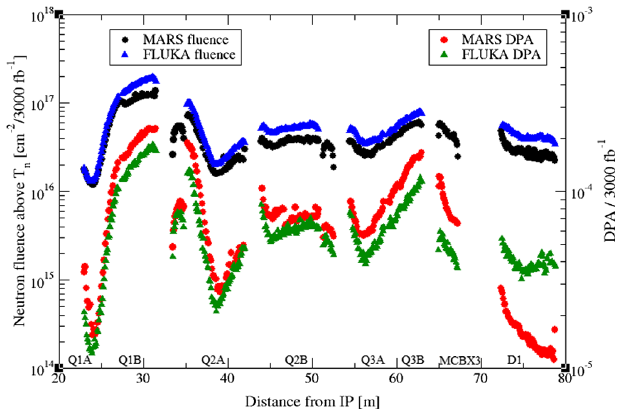
FIG. 11. Longitudinal peak neutron fluence and peak DPA profiles along the hottest regions in the IT